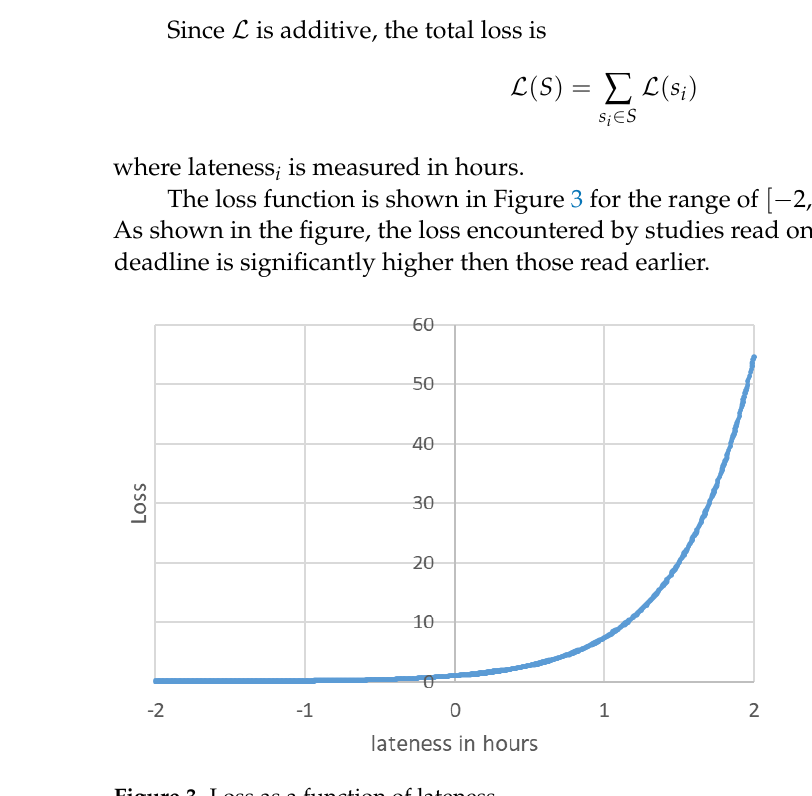
Figure 3. Loss as a function of lateness.